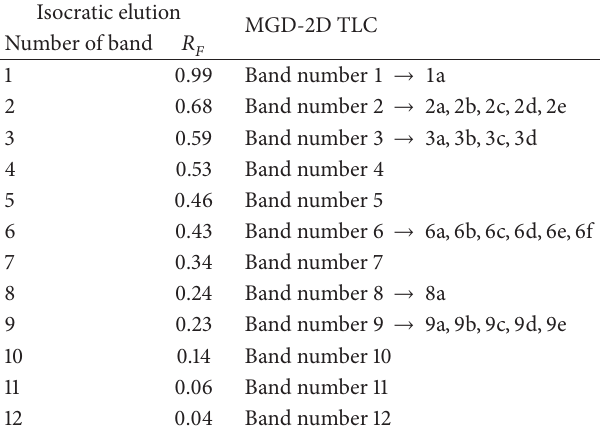
phase: toluene and ethyl acetate (94:6 v/v). The zones were deriva- tized with the anise aldehyde-sulphuric (VI) acid reagent. Table 3: The comparison of efficiency of JuniperiOleum separation by means of two methods: isocratic elution and MGD-2D TLC. Compounds applied in order of decreasing 𝑅 𝐹 value and increasing polarity. Isocratic